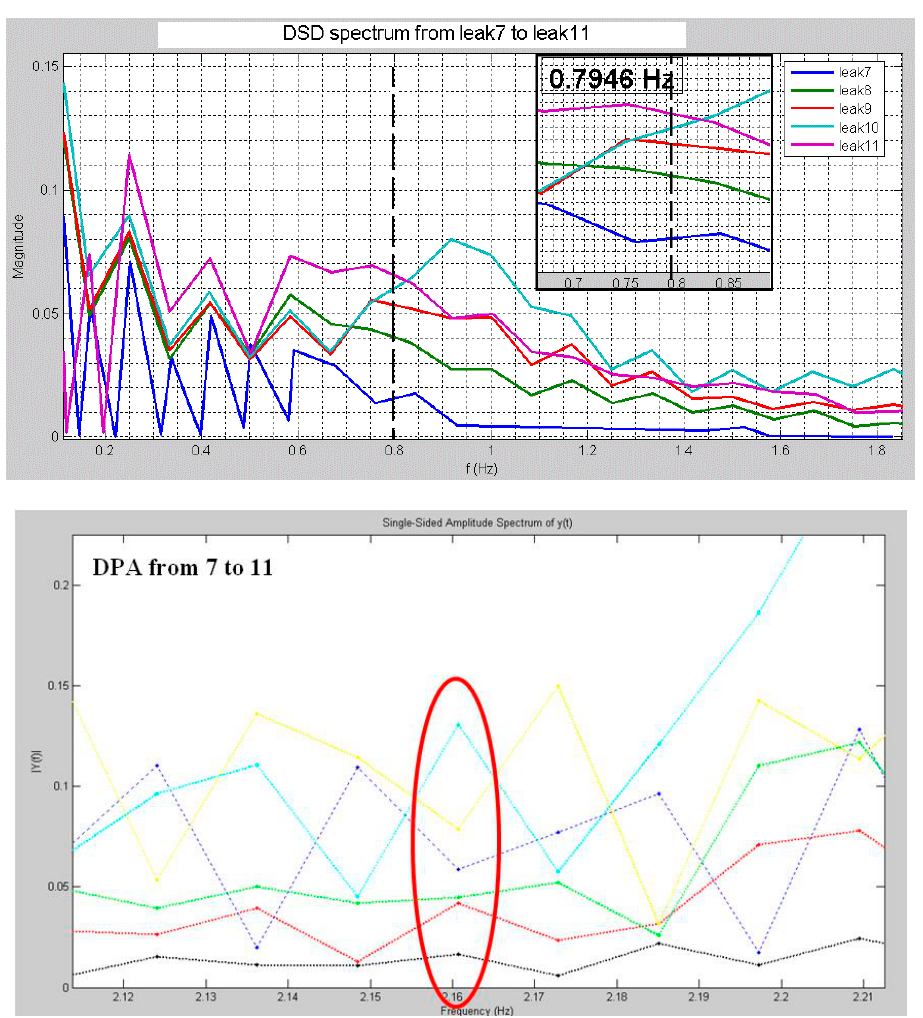
Figure 12. Detected peaks related to corresponding leaks for DSD and DPA respectively. Table 1. Final results and comparison between both techniques in two work frequencies. The uncertainty is here intended as “±”, and data have been treated using linear regression.